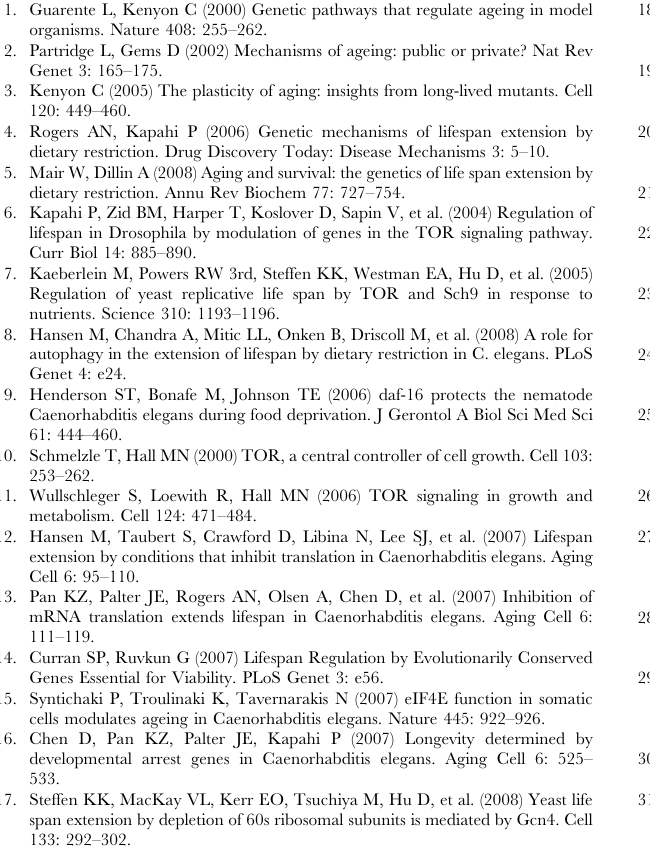
Table S3 HIF-1 functions in specific neurons and muscles to modulate DR-dependent lifespan extension. Table S4 Tissue-specific rescue of egl-9 does not affect lifespan under AL.